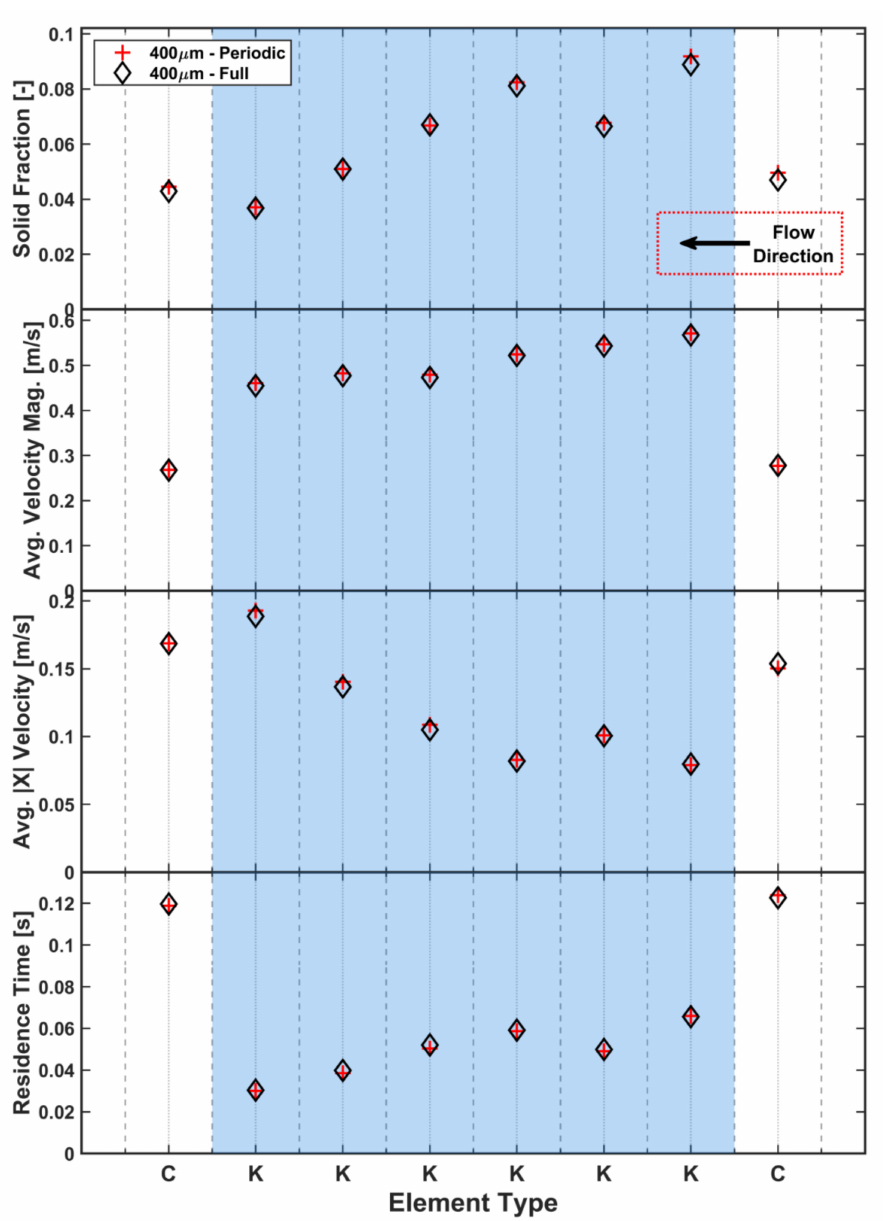
Figure 9. Comparison between periodic and full-scale simulations for various measured